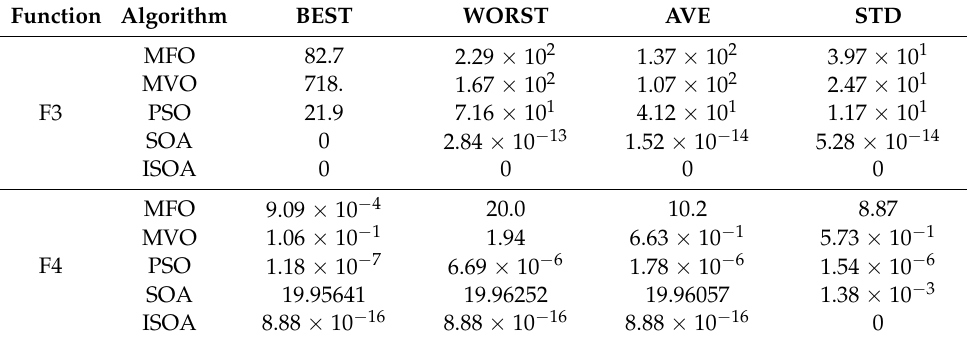
Table 3. Results of the classical multimodal functions. Function